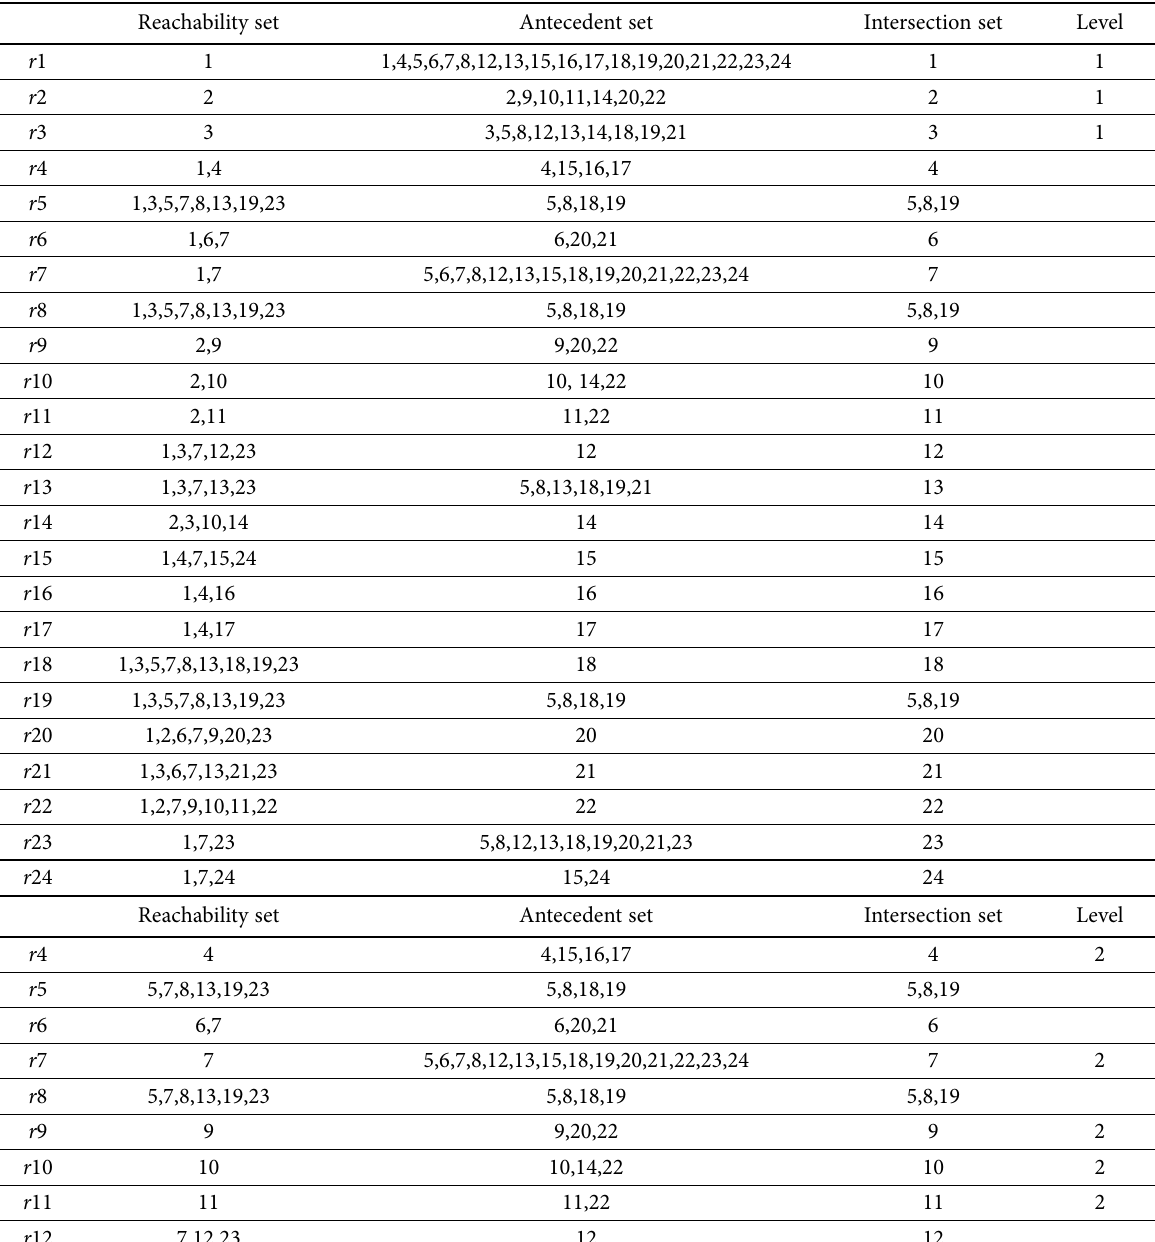
Fig. 3. Level graph of system elements Table 4. Iterations